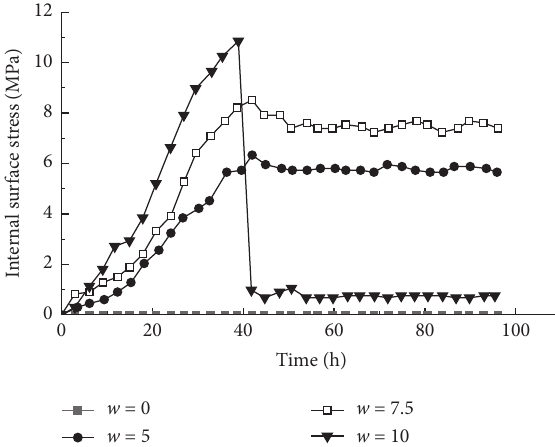
Figure 14: Curve of internal interface stress evolution without initial confinement